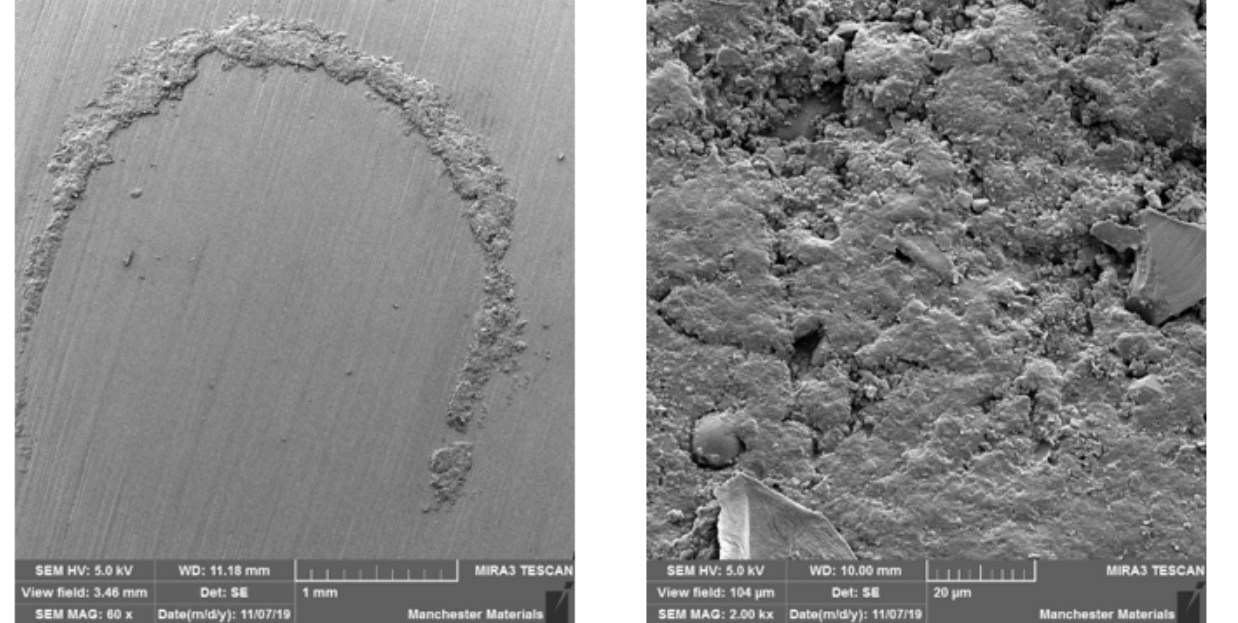
Figure 10. SEM imaging of N2 at 60 x (left) and 2 kx (right) magnification, showing exaggerated loading-induced particle debris. Note in the left image, particle debris rim surrounding the point of antagonist loading.